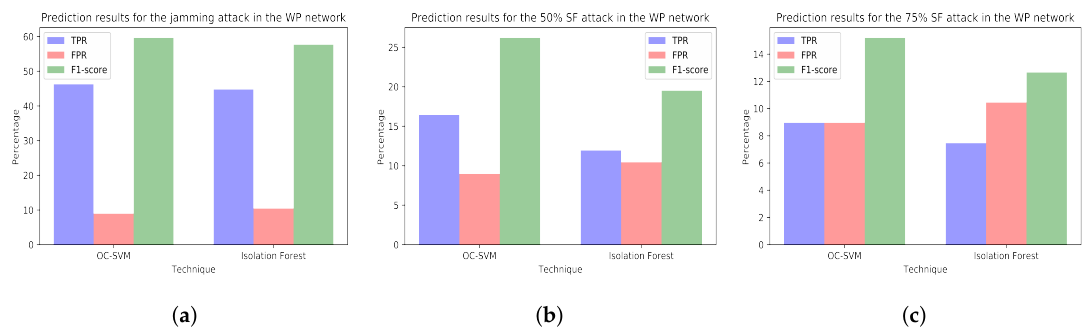
Figure 13. ( a ) prediction results for the jamming attack period using the variables from the WP network (training with dataset tr_wp and test with dataset te_wp_jam ); ( b ) prediction results for the 50% selective forwarding attack period using the variables from the WP network (training with dataset tr_wp and test with dataset te_wp_sf50 ); ( c ) prediction results for the 75% selective forwarding attack period using the variables from the WP network (training with dataset tr_wp and test with dataset te_wp_sf75